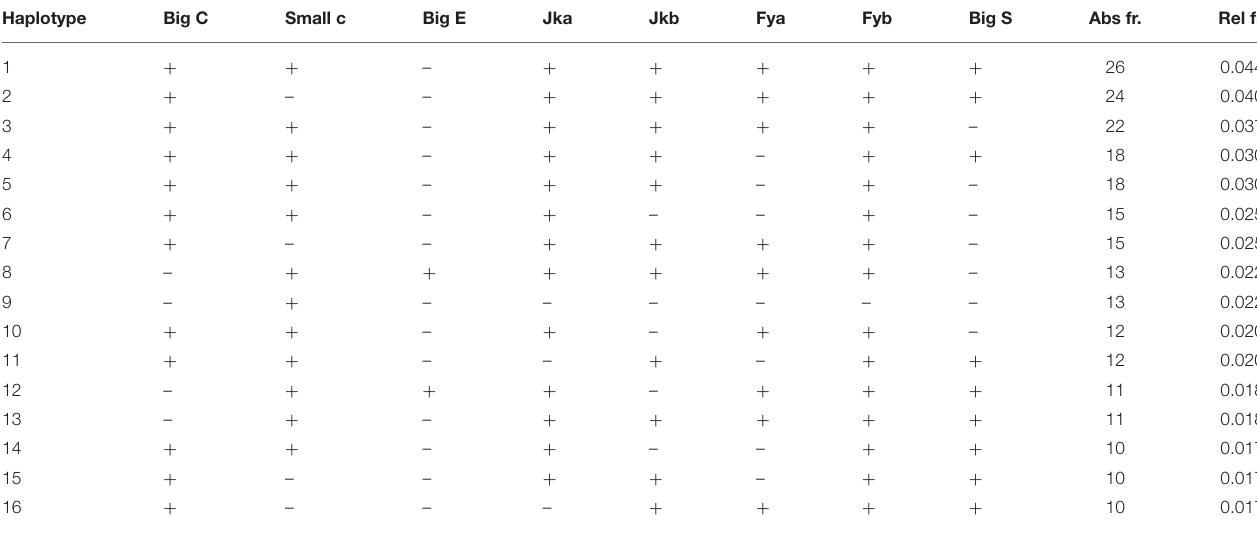
TABLE 1 | Most frequent and common haplotypes shared by the individuals of the database ( + = expression, – = non-expression of the antigen).